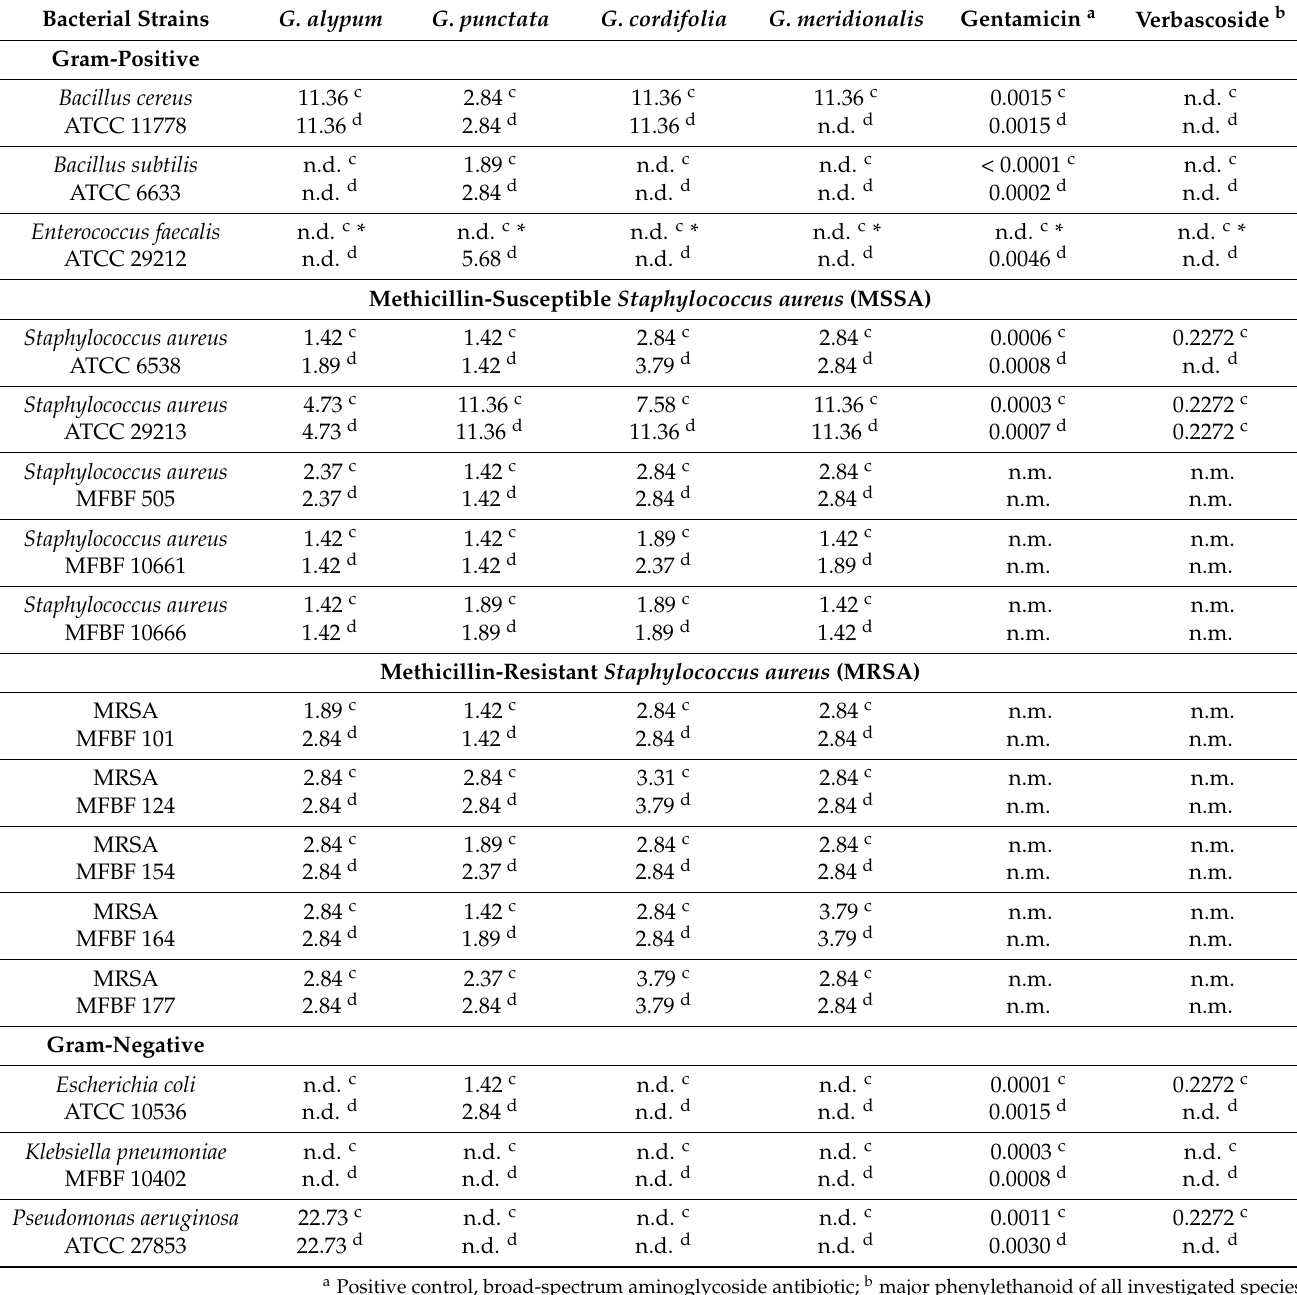
Table 8. Minimum inhibitory concentrations (MICs) and minimum bactericidal concentrations (MBCs) (mg/mL) of G. alypum , G. punctata , G. cordifolia and G. meridionalis methanolic aerial parts extracts against tested bacterial strains (mean values, n =